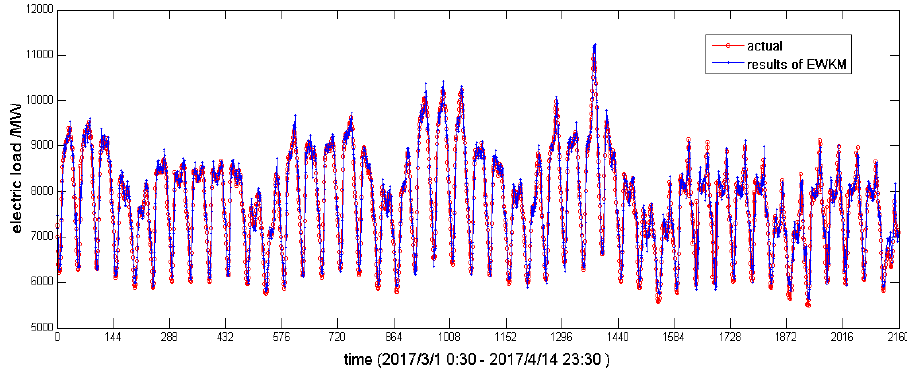
Figure 6. Plot of the original data and predictive values.